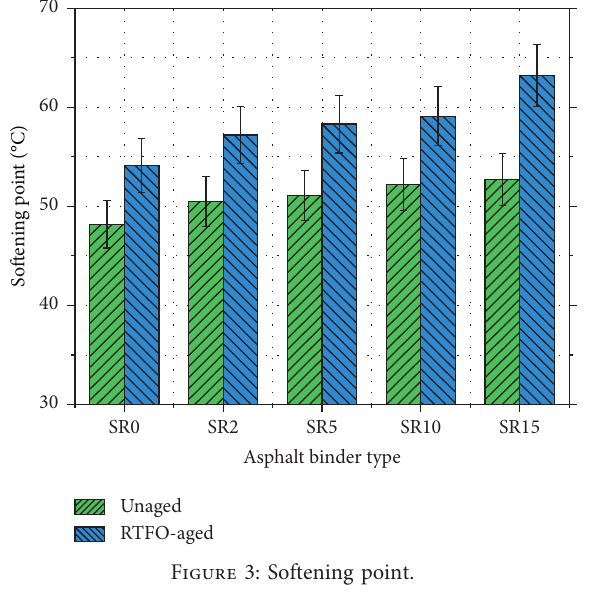
Figure 3: Softening